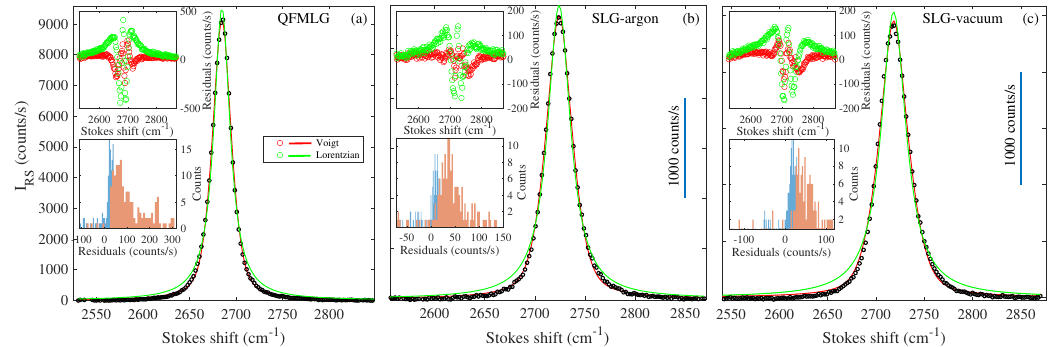
Figure 2. Line shape of the 2D peak in ( a ) QFMLG, ( b ) SLG-Ar and ( c ) SLG-vac. The black dots are the experimental data, green curve is a Lorentzian fit and red curve is the Voigt fit to the experimental data. The upper insets show the residuals for the (green point) Lorentzian and (red points) Voigt line shape. The bottom insets show the histograms of thee residuals.